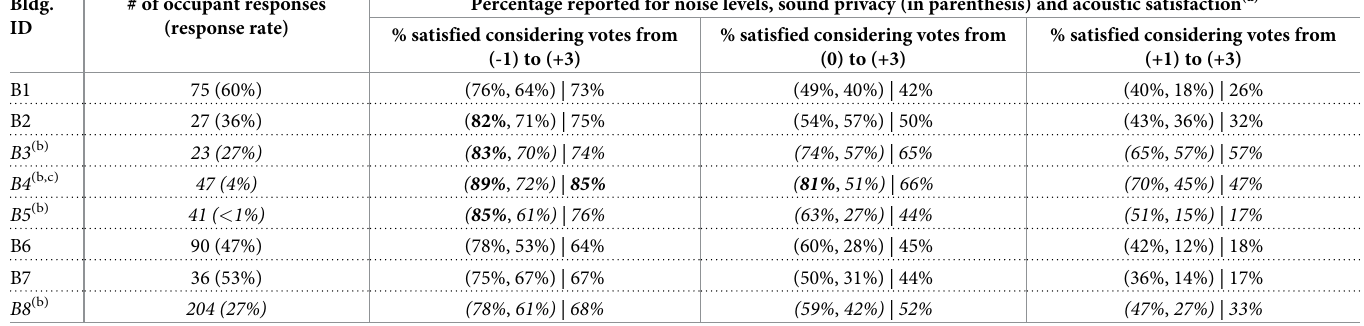
Table 4. Acoustic satisfaction by